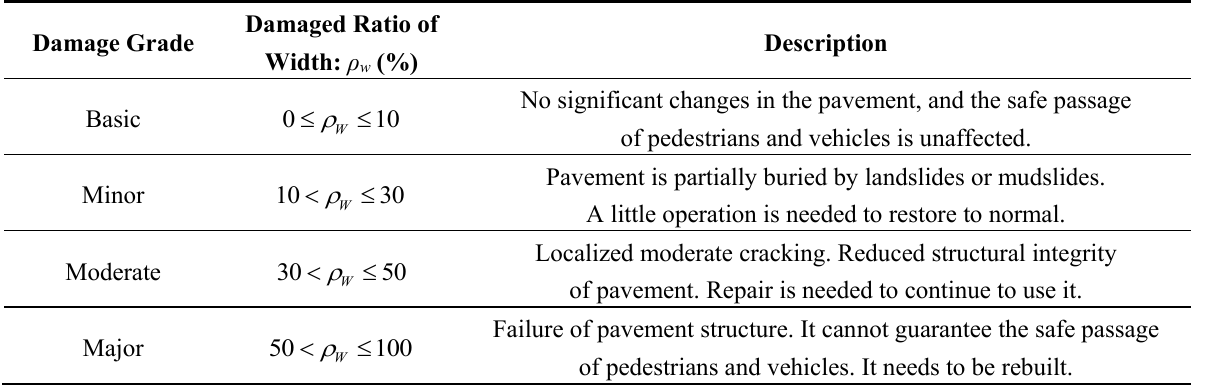
Table 1. The standard of road damage